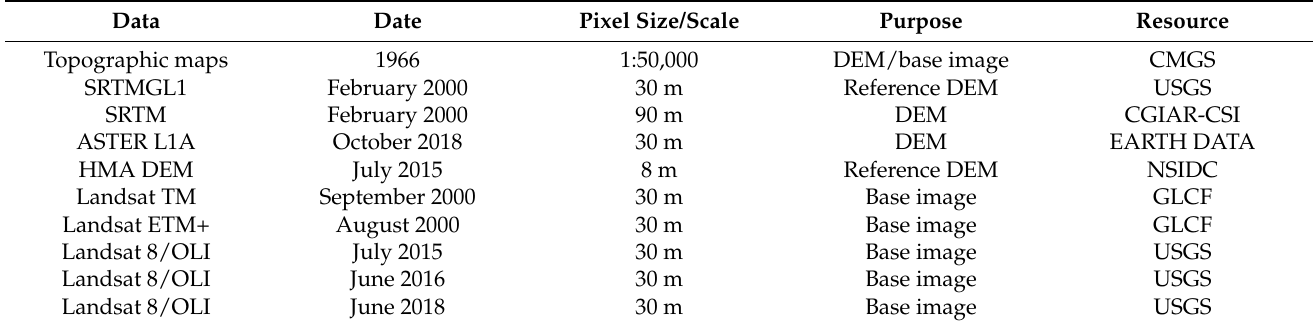
Table 1. List of data utilized for the determination of glacier changes over the A’ny ê maq ê n